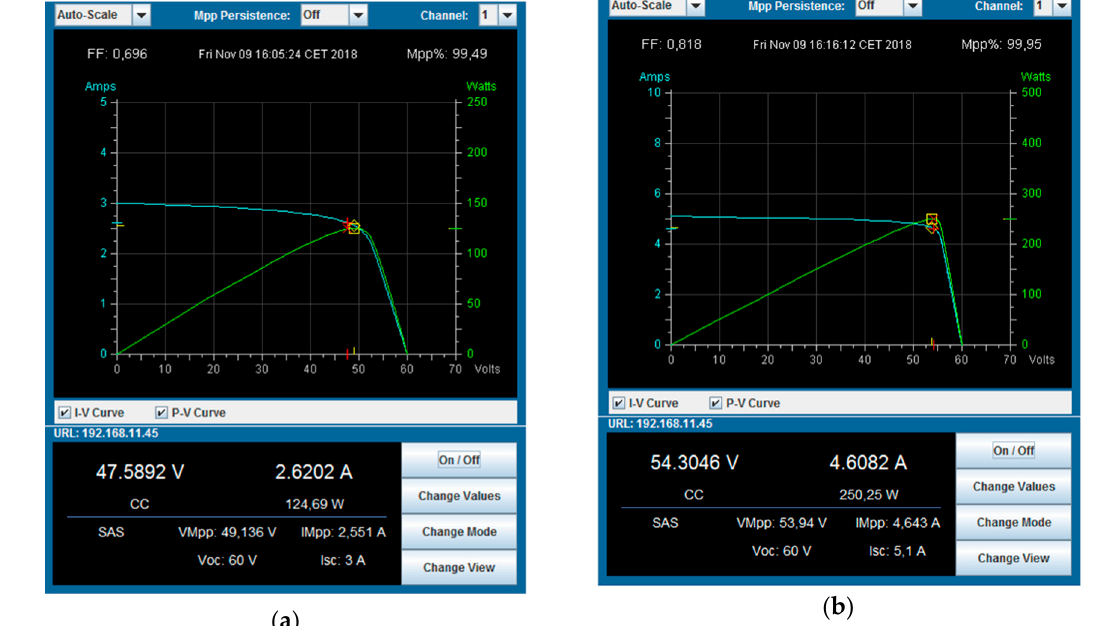
Figure 8. MPP tracking measurements for input power of 124 W ( a ) and 250 W ( b ).